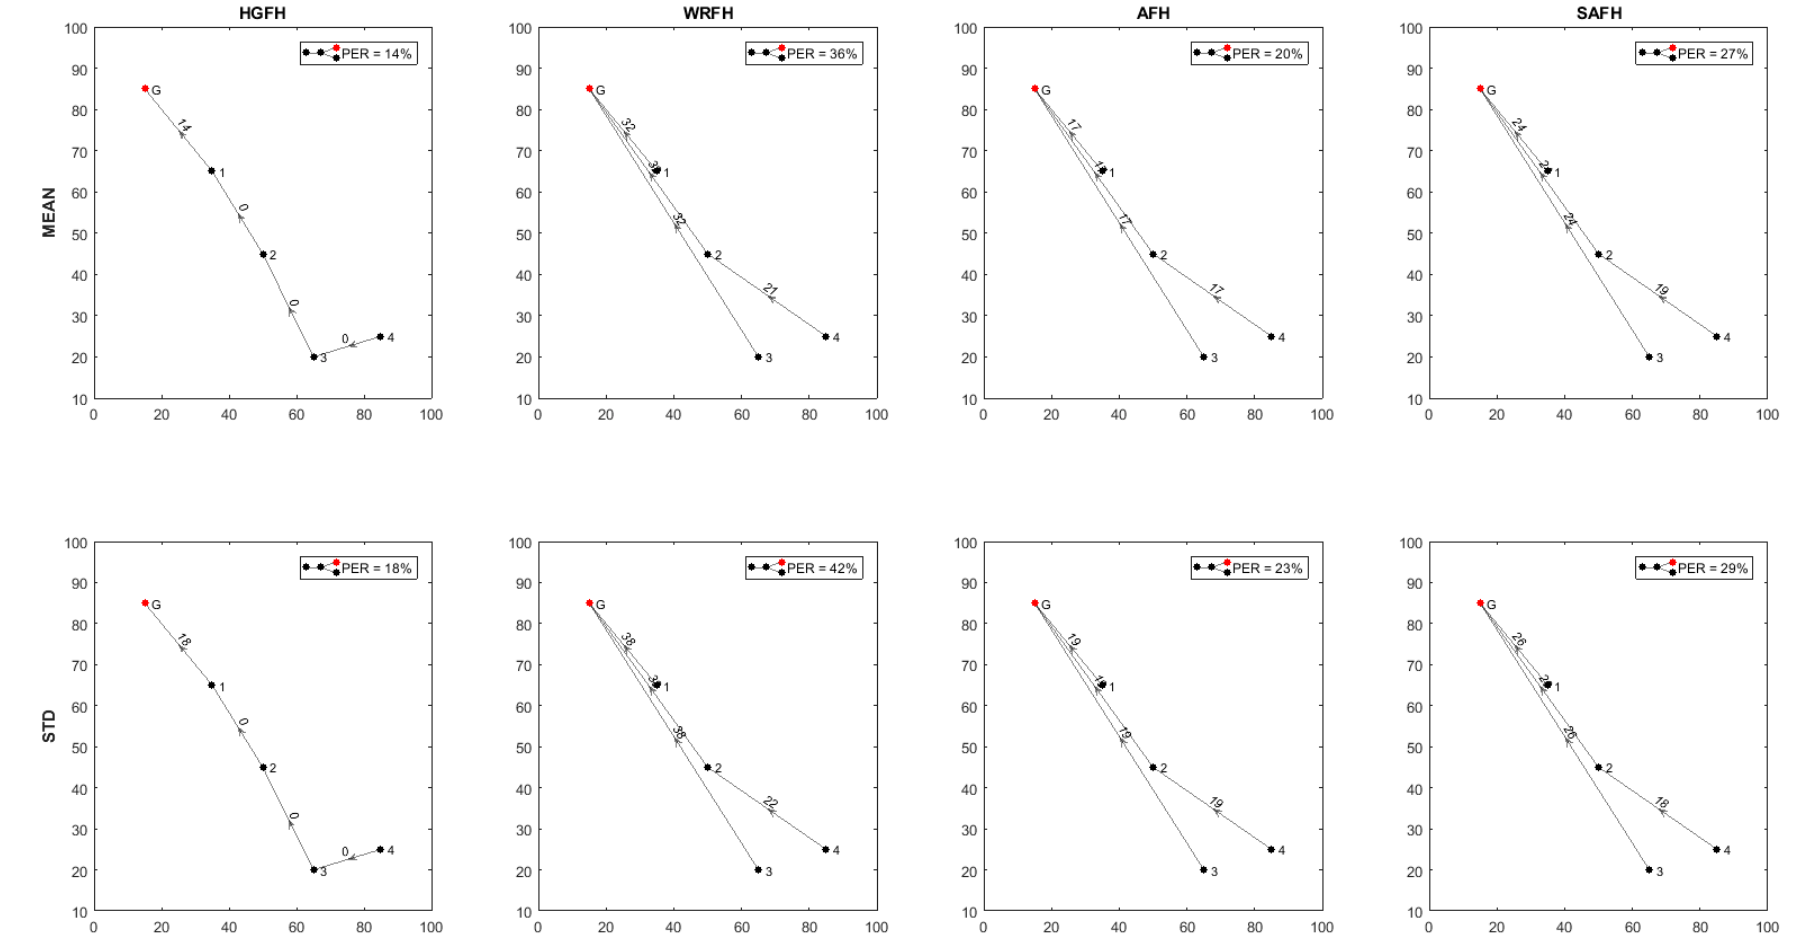
Figure 25. Inferred topologies with (cid:1875) (cid:3017)(cid:3006)(cid:3019) = 0.5 and (cid:1875) (cid:3005)(cid:3010)(cid:3020)(cid:3021) = 0.5 . Different hopping techniques and different quality metrics result in different topologies.